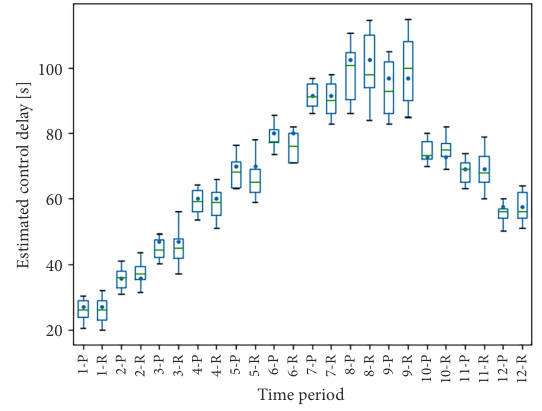
Figure 8. Box plots of resampled trajectories (P – proposed method, R – reference method)